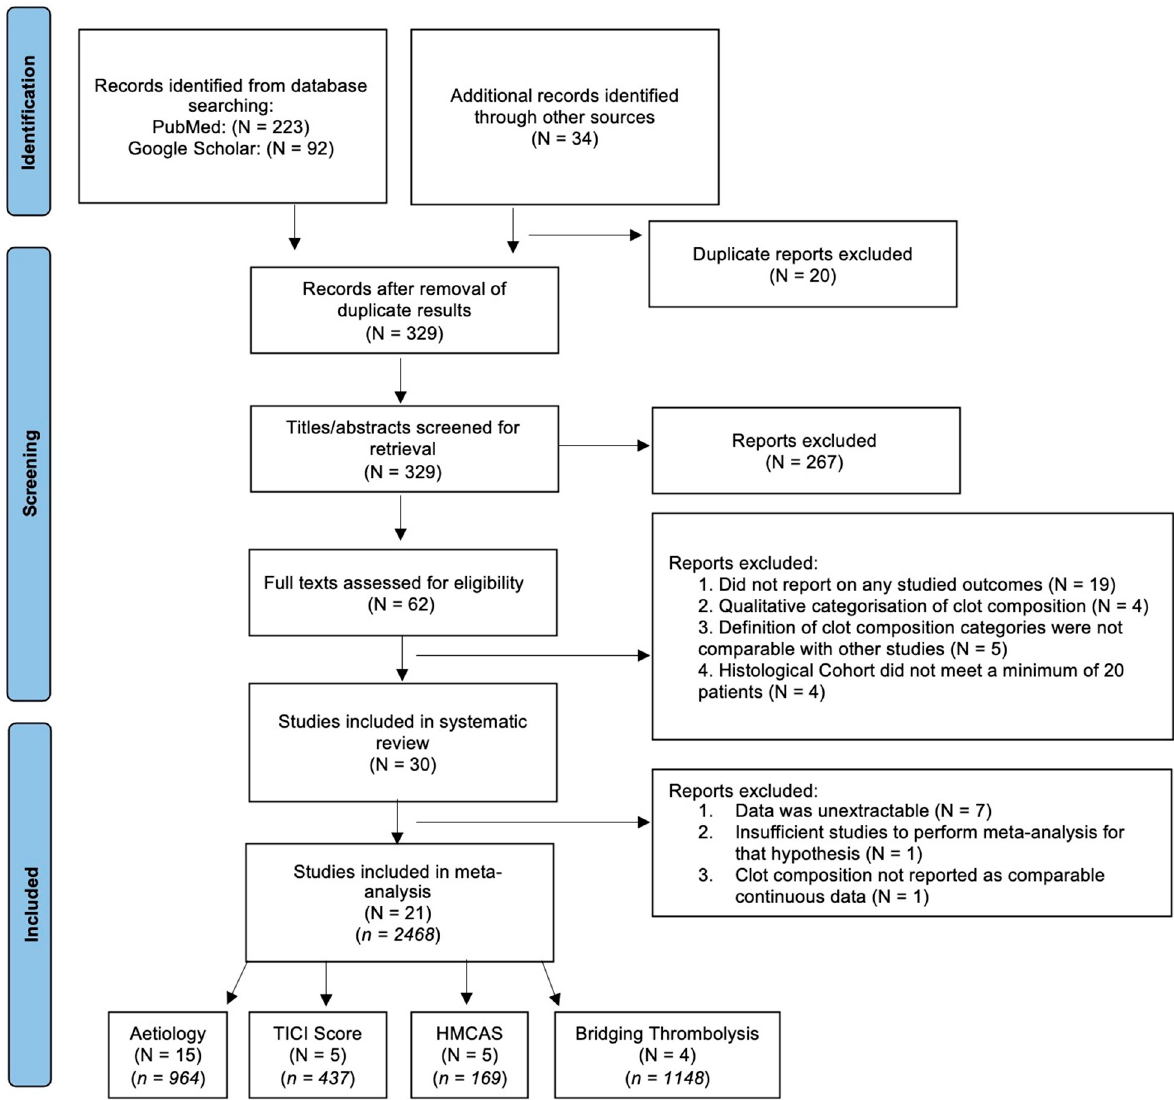
Figure 1. PRISMA Flowchart. Abbreviations: TICI: Thrombolysis in Cerebral Infarction scale, HMCAS: Hyperdense Middle Cerebral Artery Sign, N: Number of Studies, n: Number of Patients.